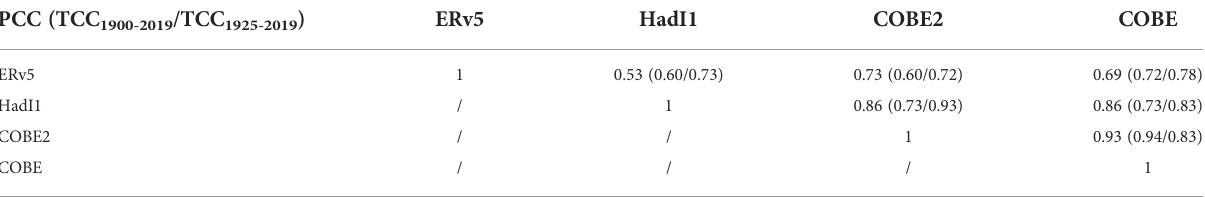
The numbers outside (inside) the parentheses are the PCC (TCC) of the AMO spatial pattern (index) over the North